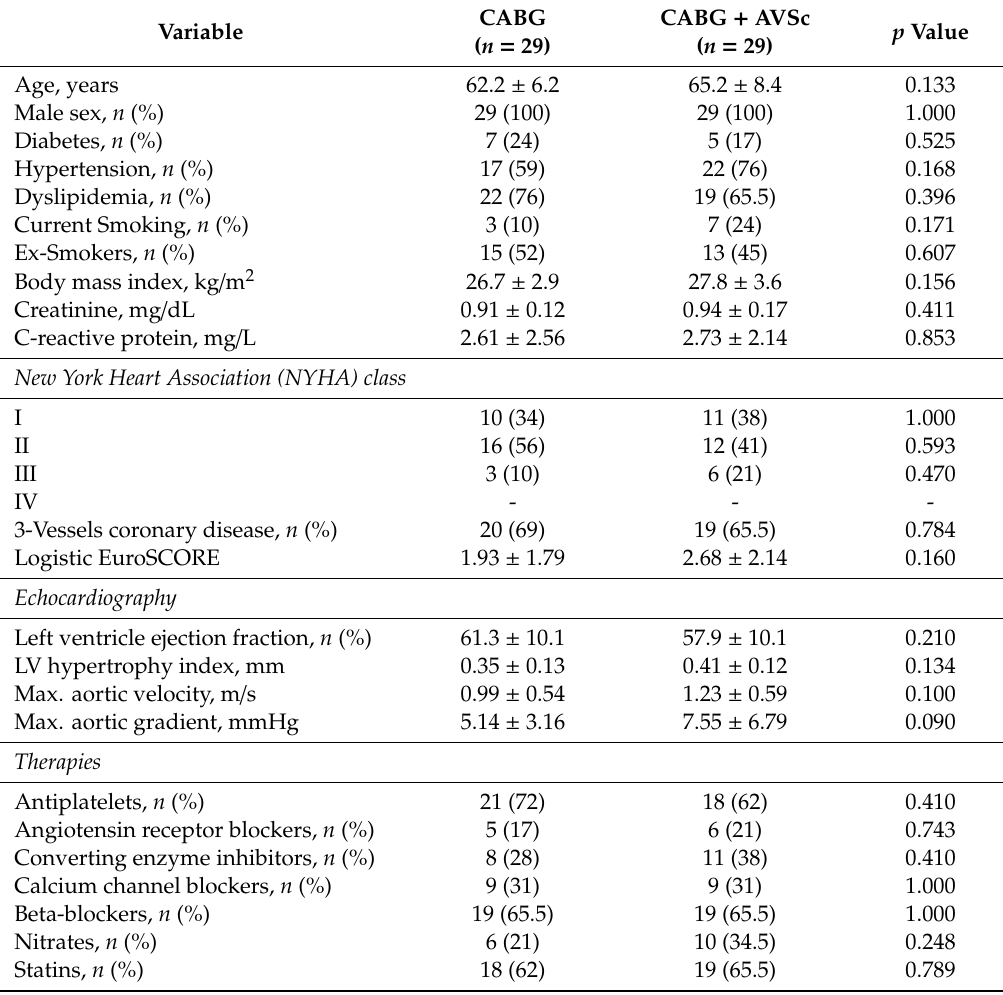
Table 1. Patient